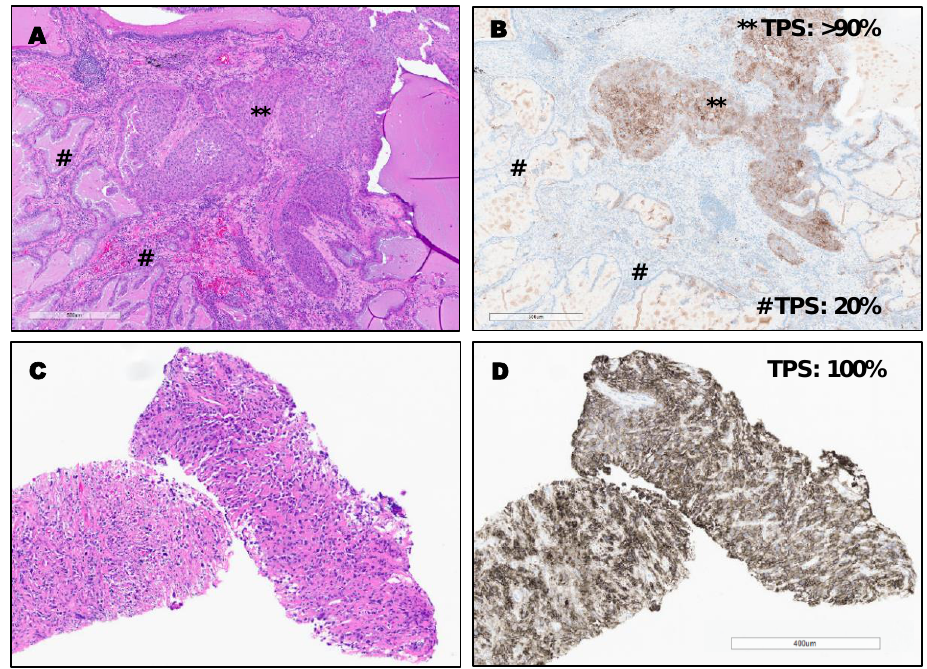
Figure 4. ( A , B ): Invasive adenosquamous carcinoma with high expression in squamous carcinoma component (TPS: >90%) and intermediate expression in the adenocarcinoma component (TPS: 20%) by using PD-L1 (22C3) FDA (Keytruda ® ). ** TPS: >90% (squamous carcinoma component). # TPS: 20% (adenocarcinoma component). Bottom ( C , D ): Sarcomatoid/Pleomorphic carcinoma with diffuse PDL1 staining (TPS: 100%) by using PD-L1 (22C3) FDA (Keytruda ®